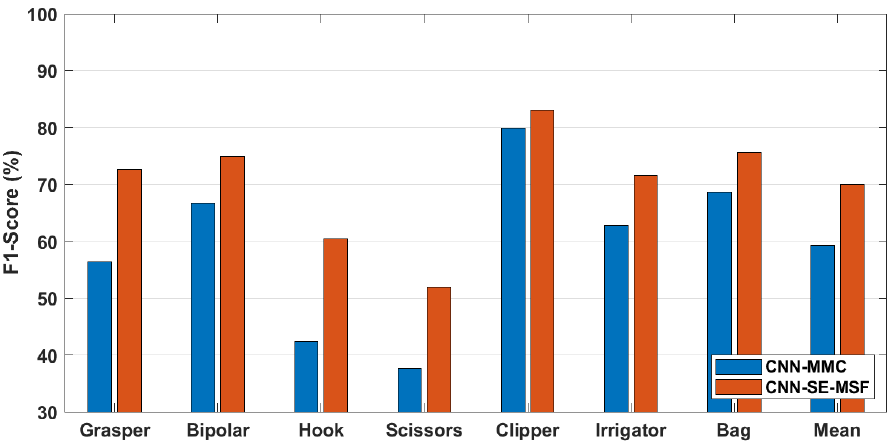
Figure 4. Tool localization F1-score on the Cholec80-Boxes dataset. Note the truncated scale of the